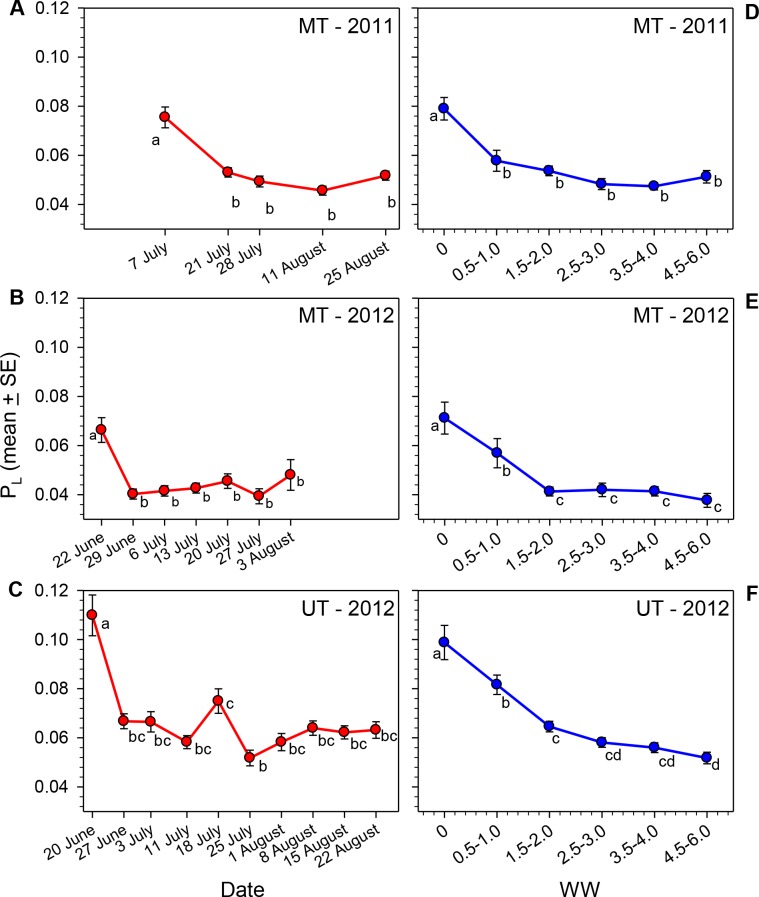
Seasonal changes in the relationship of PL for female M. rotundata to date of collection (A–C; red lines) and WW (D–F; blue lines).Means associated with different letters are significantly different at P < 0.05 (SNK Test).